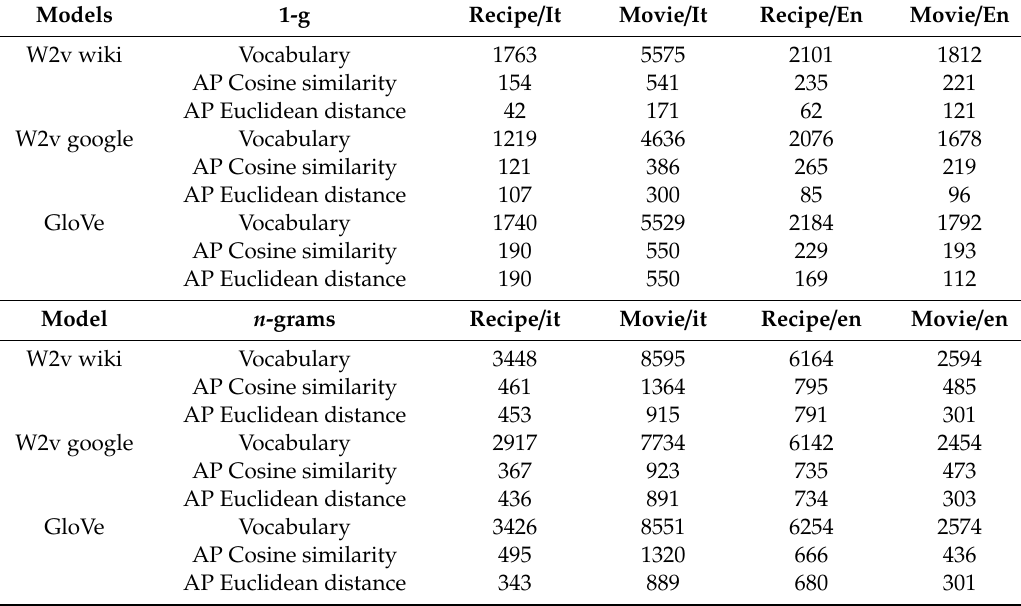
Table 5. Number of clusters per models and per similarity metrics found by the A ffi nity Propagation (AP) algorithm, for 1-g and n